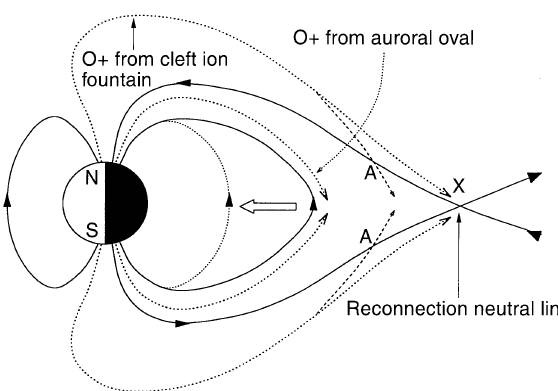
Fig. 1. A schematic illustration of the respective paths into the magnetosphere of O (cid:96) ions from the dayside cleft and the nightside auroral ionosphere. The empty arrow represents the dipolarisation convection surge. X marks the tail reconnection neutral line. Recon- nection at X allows cleft-ion-fountain plasma to cross the open/closed field line boundary closer to the Earth (at A)